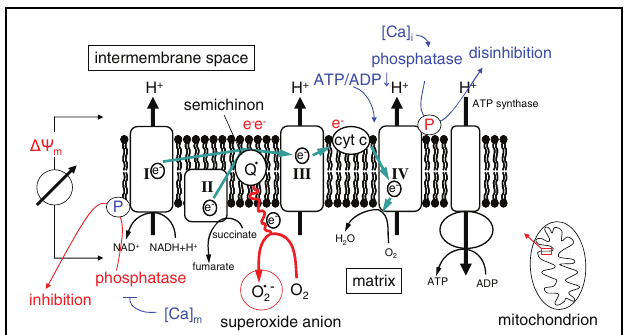
FIGURE 3 | Mitochondrial ROS formation in dependence on (cid:2)(cid:3) m (I, II, III, and IV, electron transport complexes I, II, III, and IV; Q: semiquinone radical; cyt C: cytochrome C). Ca 2 + and the ATP/ADP ratio regulate the electron chain at complexes I and